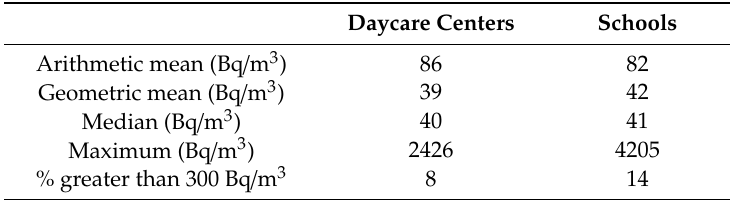
Table 2. Main descriptive statistics of indoor radon measured in daycare centers and schools in the